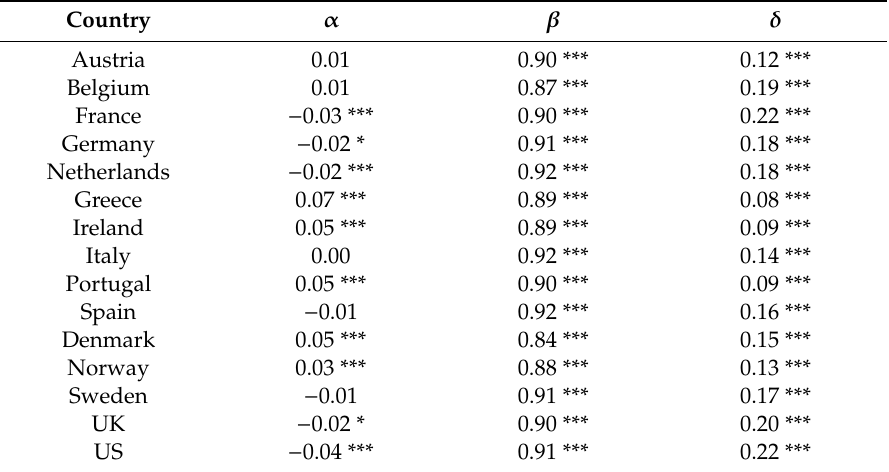
Table A1. Estimation of conditional